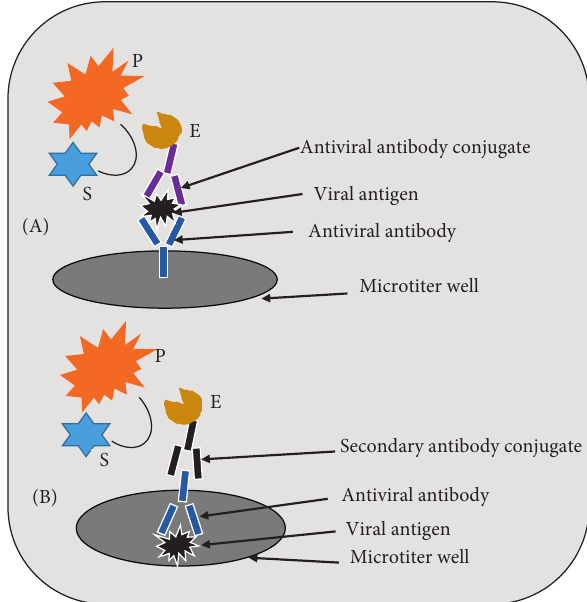
Figure 4: Diagram of the two principles of ELISA. (A) Sandwich ELISA. (B) Indirect ELISA. Abbreviations: E, enzyme; S, substrate; P,